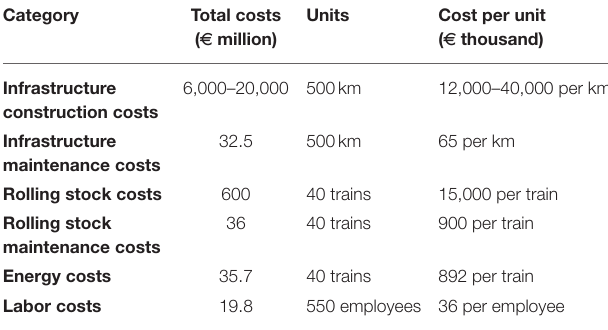
TABLE 6 | Estimated costs of a 500km HSR line in Europe in 2004